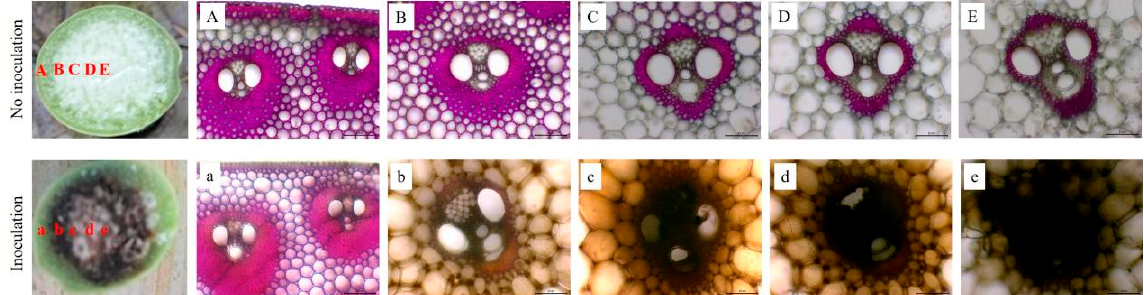
Figure 7. Infection of the vascular bundle in the internode cross section on the 20th day after the inoculation of Pythium aristosporum (Dika517, 2018). ( A , a ) indicate the cortex; ( B , b ) indicate a quarter of the cortex to center of pith; ( C , c ) indicate the half of cortex to center of pith; ( D , d ) indicate three quarters of the cortex to center of pith, and ( E , e ) indicate the center of pith.